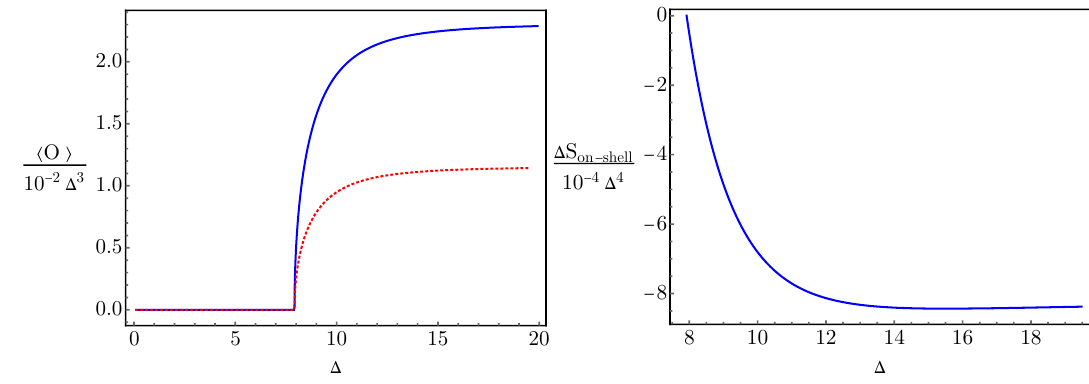
Figure 1 . Left: order parameter h O i = (cid:1) 3 as a function of (cid:1) for the nematic (solid blue) and xy nematic condensate (dotted red) phases. Right: di(cid:11)erence of free energies between the xy nematic condensate phase and the normal